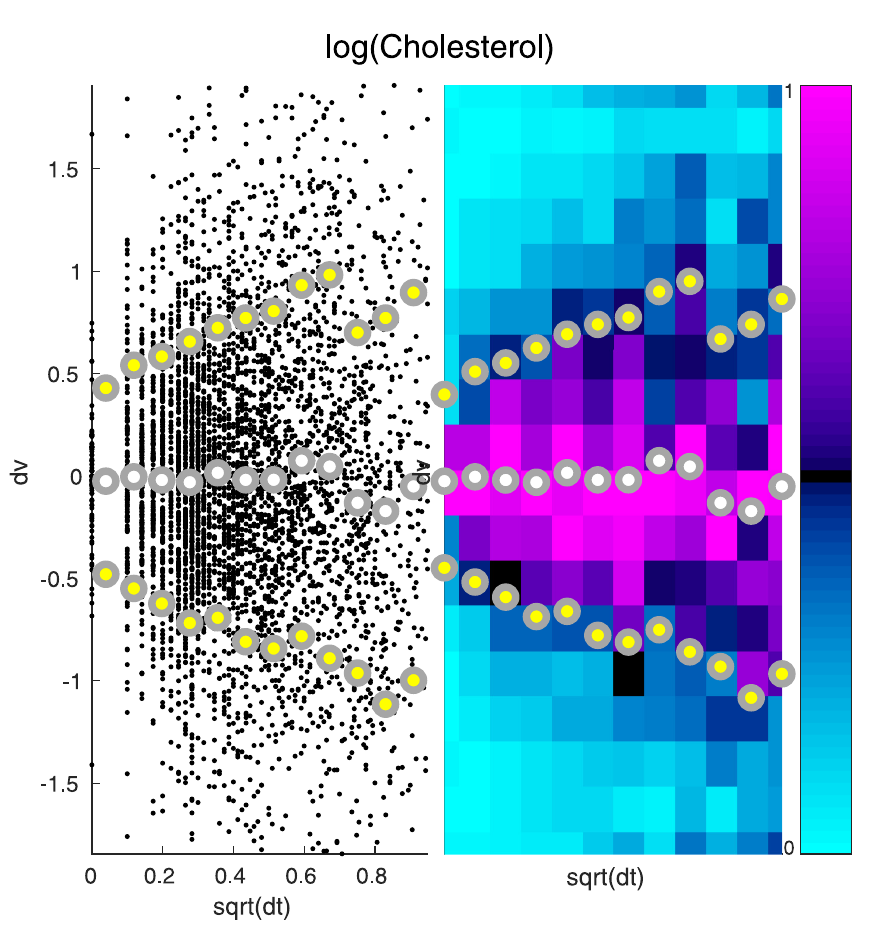
Fig 2. Increments of Cholesterol. Here we illustrate the distribution of increments associated with Cholesterol. The format for this figure is the same as Fig